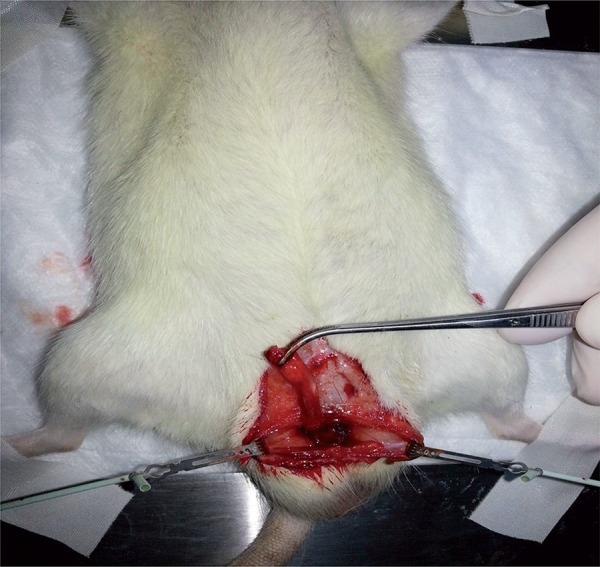
Dissected rat penis.